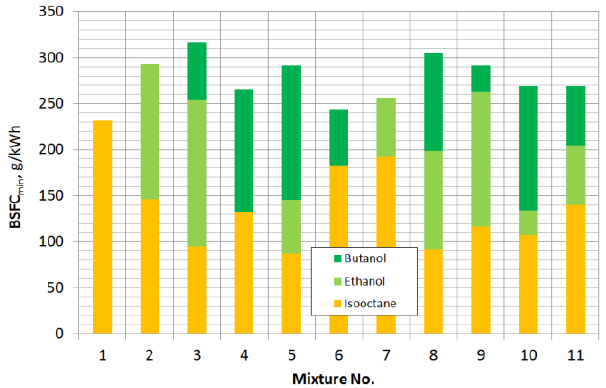
Fig. 4. BSFC min by each blends